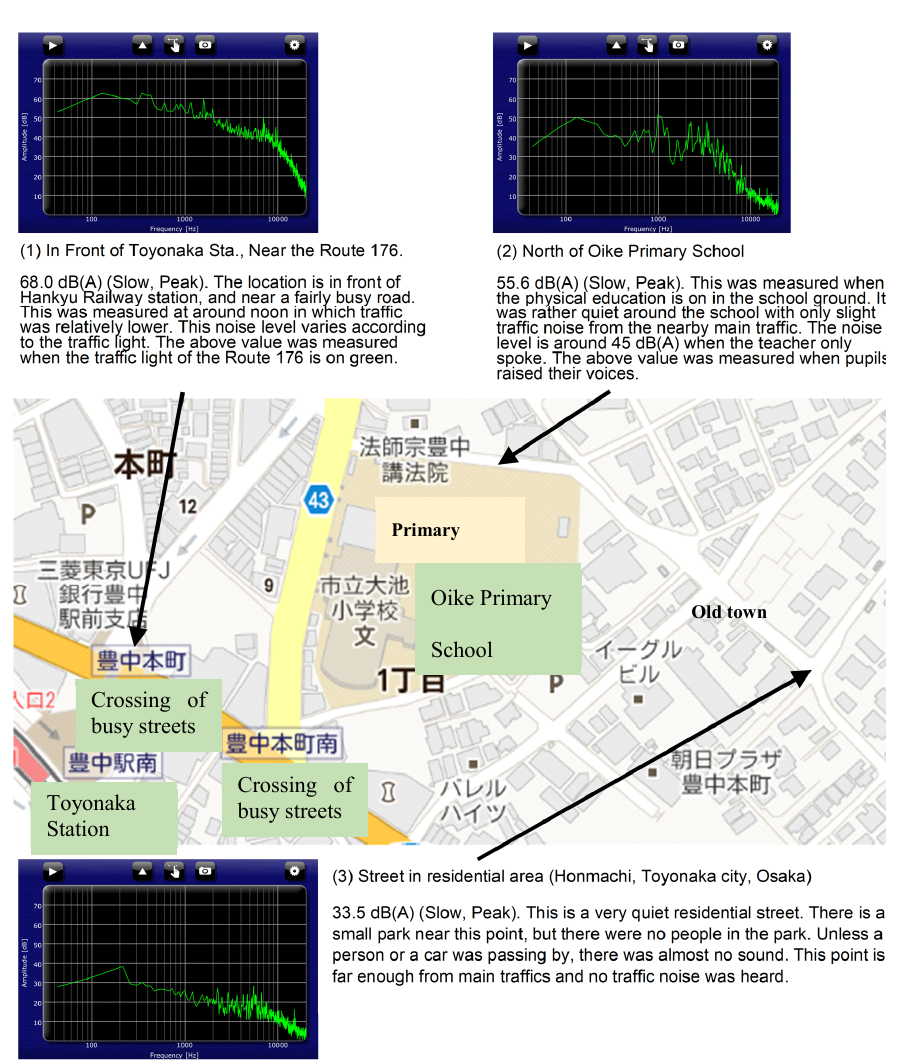
Figure 3. Example of a sound map with sound pressure levels (SPLs) and sound spectra: Honmachi area, Toyonaka City, Osaka, Japan, a mid-sized, moderately urbanized city [12].